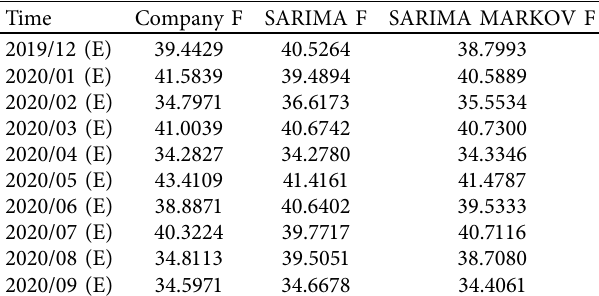
Figure 8: SARIMA-Markov model fitting diagram. Table 5: Statistics of the prediction results (in million tons). Table 7: Statistics of the forecast results (in million